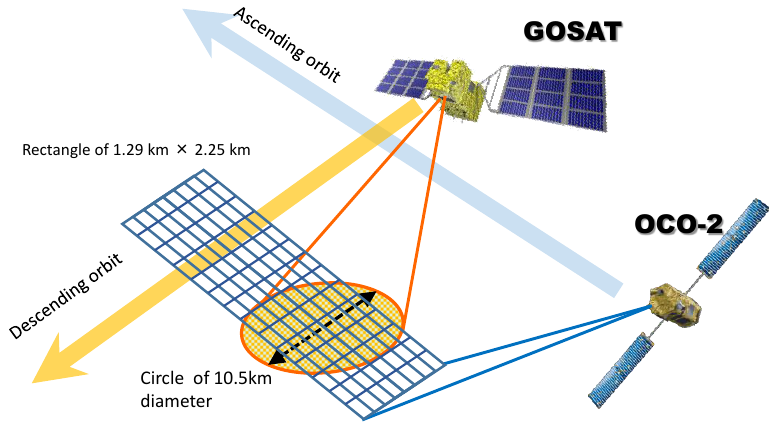
Figure 1. GOSAT and OCO-2 orbit direction and observation strategy.